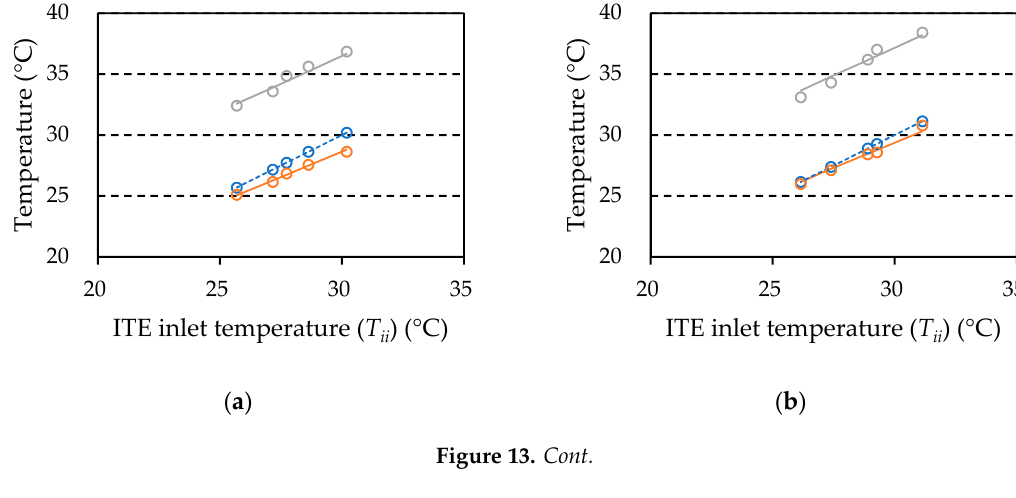
( d ) Figure 13. Experimental and prediction results for supply-air temperature ( T co ) and return-air temperature ( T ci ) with respect to ITE inlet temperature ( T ii ): ( a ) C-1, ( b ) C-2, ( c ) D-1, and ( d ) D-2. 6. Proposed Method for Optimization of Total Energy of a Machine Room In the previous section, it was confirmed that the thermal environment of the machine room can be predicted by the proposed prediction procedure; in particular, the temperatures of the